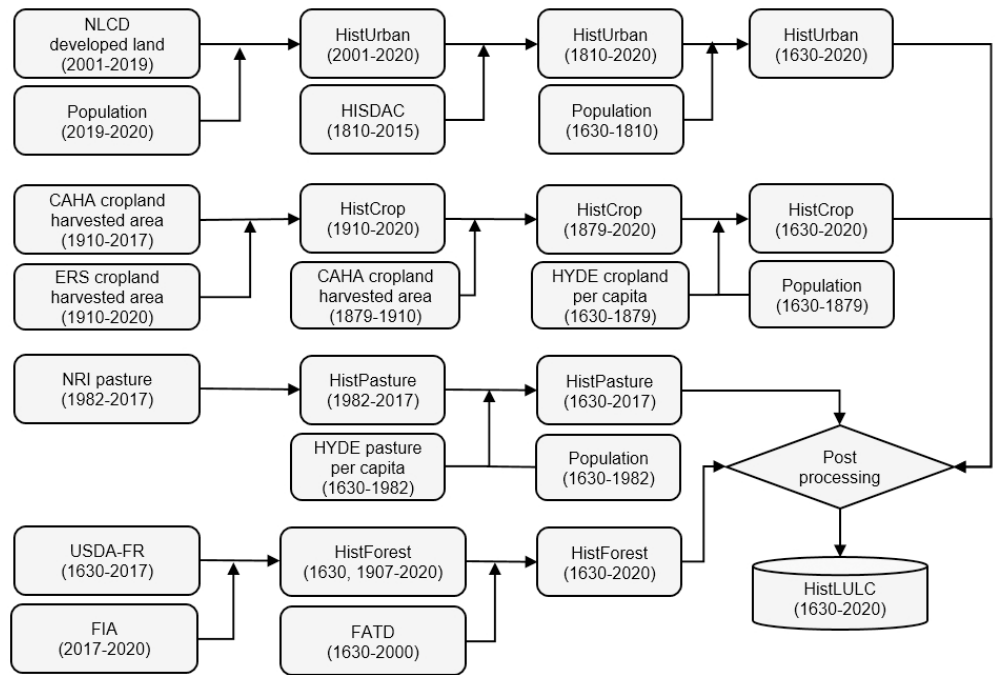
Figure 3. Workflow for reconstructing historical land use and land cover area at the state level. NLCD: National Land Cover Database; HISDAC: Historical Settlement Data Compilation; ERS: Economic Research Service; CAHA: Census of Agriculture Historical Archive; NRI: National Resource Inventory; HYDE: History Database of the Global Environment; FIA: Forest Inventory and Analysis; USDA-FR: USDA Forest Resources of the United States, 2017; and FATD: Forest Area Trend Data. HistUrban, HistCrop, HistPasture, HistForest, and HistLULC refer to historical urban land, historical cropland, historical pasture, historical forest, and historical land use and land cover.